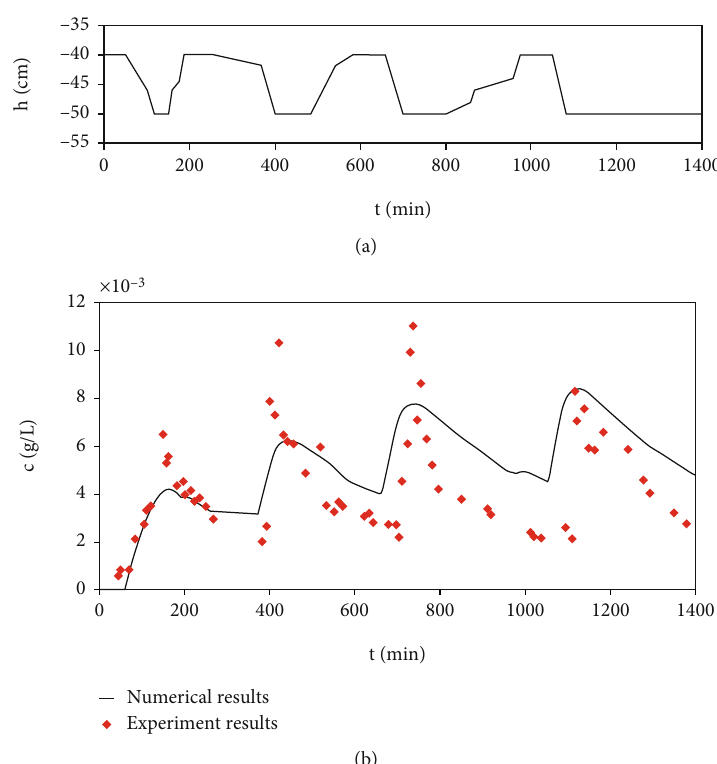
Figure 2: Comparison between experimental and numerical